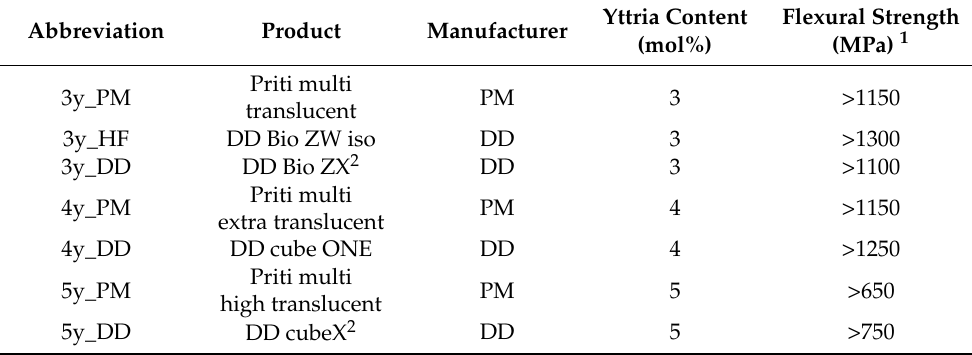
Table 1. List of the used sample plates from the manufactures pritidenta GmbH (Germany, PM) and Dental Direct GmbH (Germany, DD). HF means “high-strength”, a product of DD, according to its own description with higher strength and lower translucency than the other three yttria-stabilized